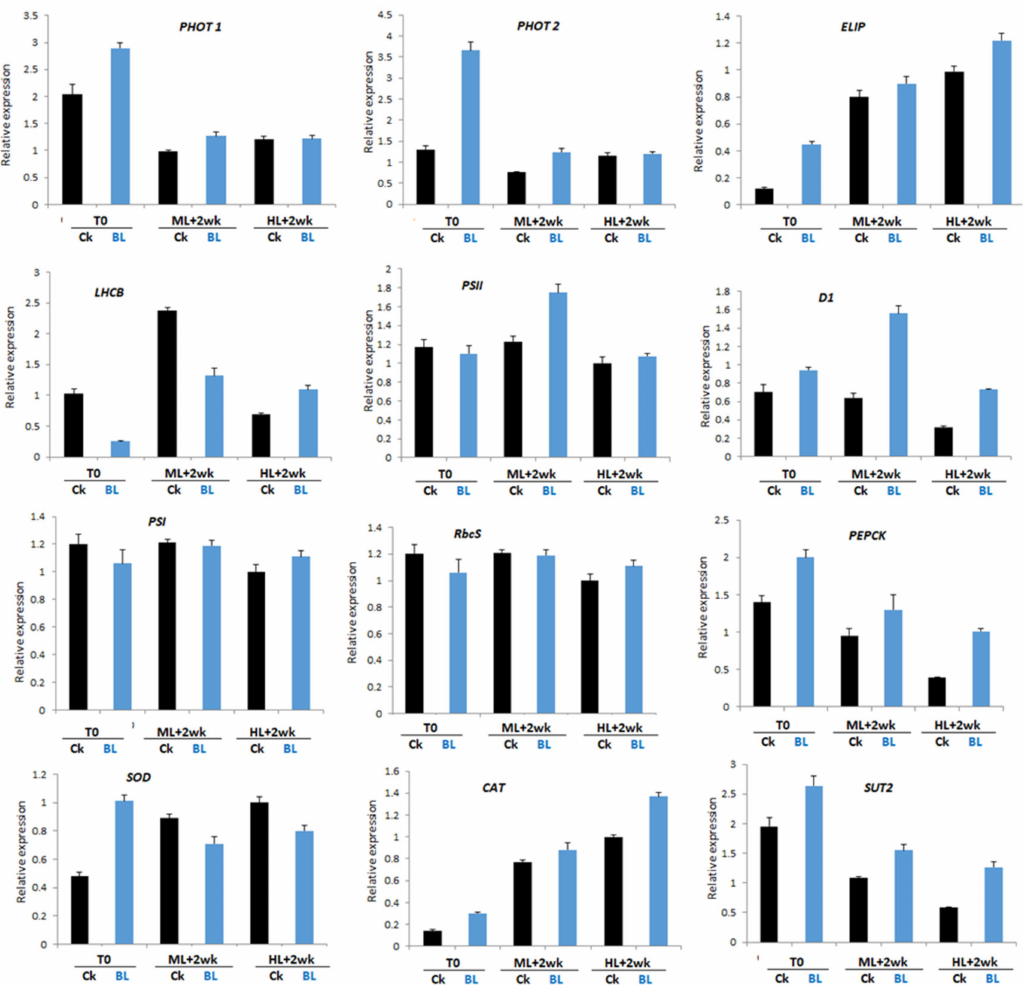
Figure 8. Quantitative RT-PCR shows that blue light treatment alters the gene expression patterns of young orchid seedlings. RNA samples were collected from young seedlings at two weeks after exposure to moderate light at 500 µ mol m 2 s − 1 (ML) or high light at 1000 µ mol m 2 s − 1 (HL). Error bars indicate the SD of the mean from three